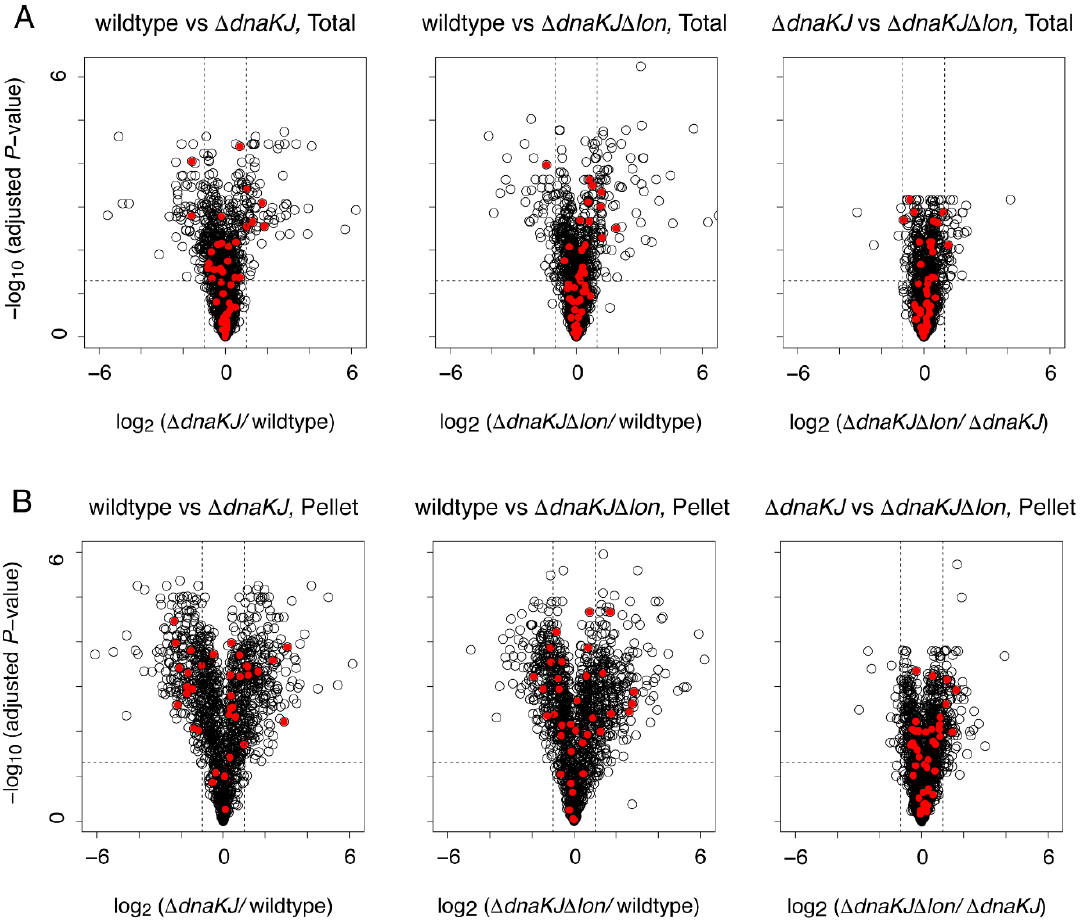
Figure 2. Proteome changes of the in vivo obligate GroE substrates by DnaK/DnaJ deletion. ( A ) Proteome changes of Δ dnaKJ and Δ dnaK J Δ lon in the total fraction depicted as volcano plots. The horizontal axis indicates the value of the fold changes taken as log 2 , and the vertical axis indicates p -values by Welch’s t -test (two-sided) with three technical replicates in each sample taken as − log 10 . For multiplicity correction, the p -values are adjusted by the Benjamini-Hochberg method. Red dots indicate the in vivo obligate GroE substrates. ( B ) Proteome changes of Δ dnaKJ and Δ dnaKJ Δ lon in the pellet fraction depicted as volcano plots. Red dots indicate the in vivo obligate GroE substrates. Table 2. Fold change values of the in vivo obligate GroE substrates for Δ dnaKJ and Δ dnaKJ Δ lon strain.